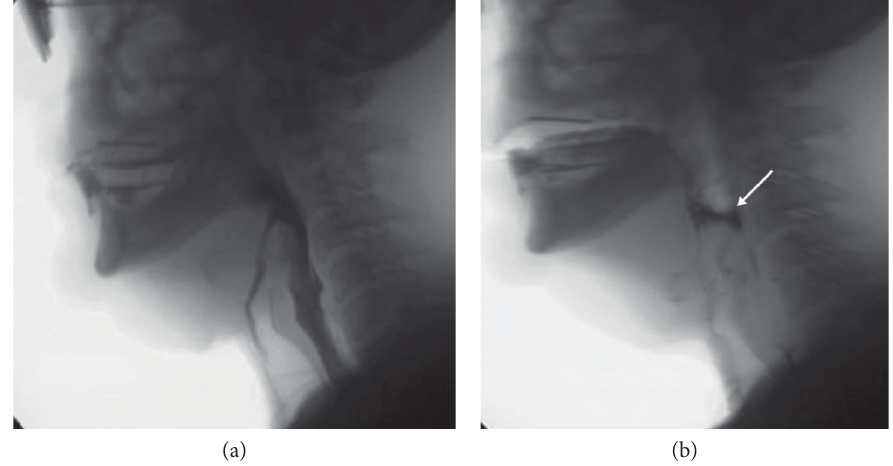
Figure 3: Lateral fl uoroscopic view of a 51-year-old man who has undergone a supracricoid laryngectomy. The bolus enters the airway and passes below the vocal folds, and no e ff ort is made to eject. This represents a penetration and aspiration score of 8 (a). (b) Cricopharyngeal dysfunction with residue in the pharynx, white